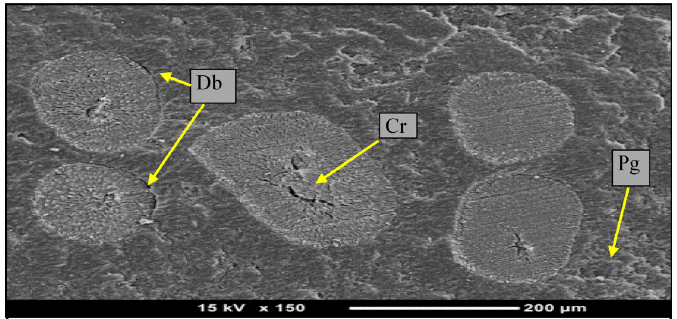
Figure 10. Micrographs of 3% graphite/date palm fiber/epoxy after tensile